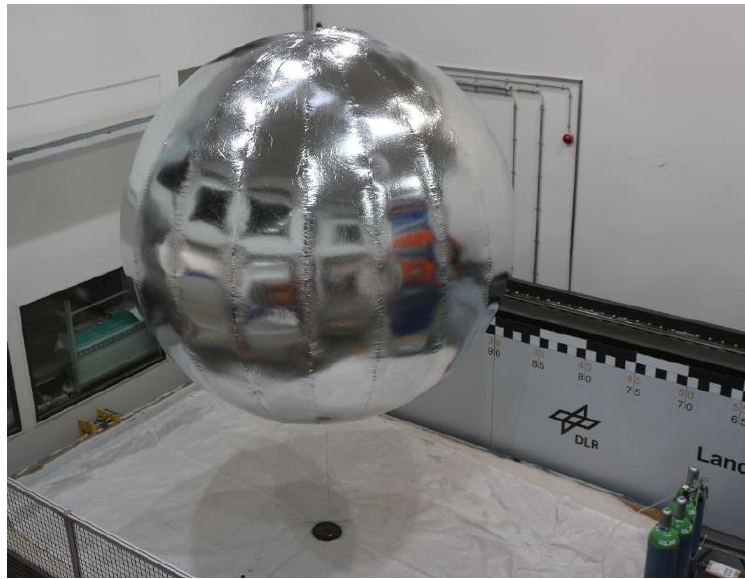
Figure 7. A 3.25 m test sphere in DLR’s Landing and Mobility Test Facility.